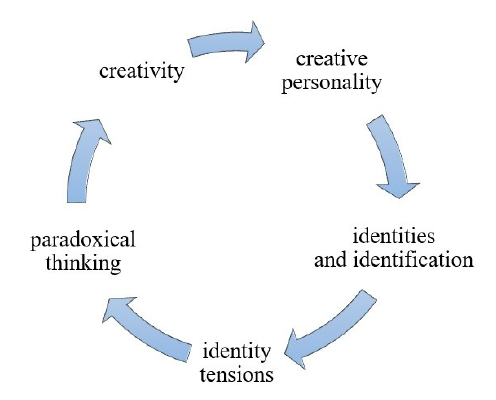
Figure 1. Creativity development model (source: created by